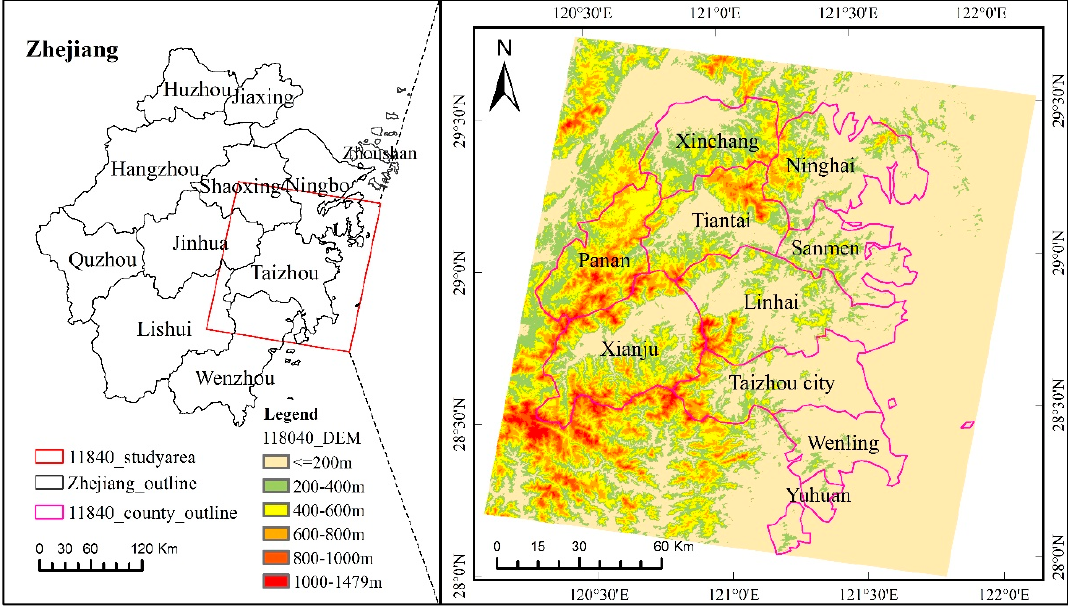
Figure 1. Study area showing relatively flat regions in eastern coastal areas of Zhejiang Province, China, and high elevations in the western mountainous regions.